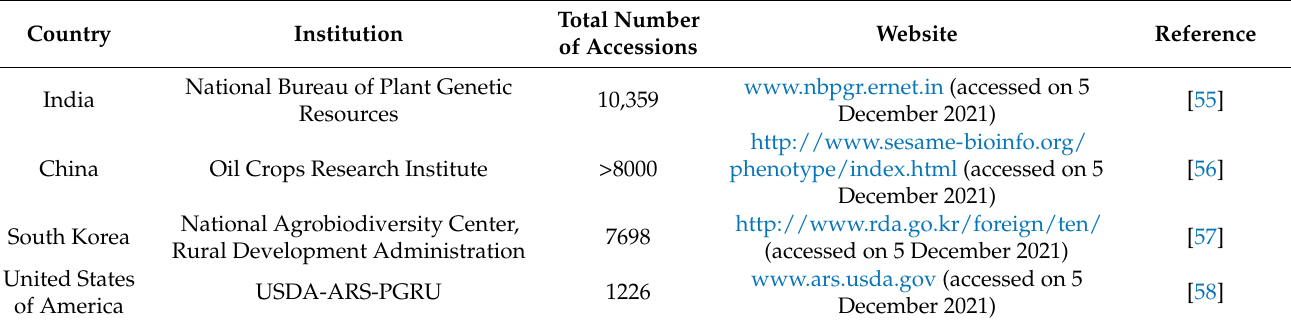
Table 4. The major sesame gene banks